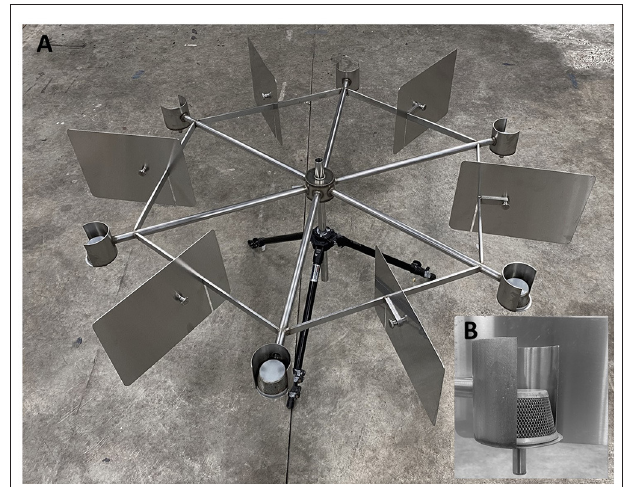
FIGURE 1 | Testing Wheel Image: (A) Stainless-steel testing wheel with 6 radial arms and sample divider plates between positions; (B) Walled (3/4 circumference) cups and wire basket for sample